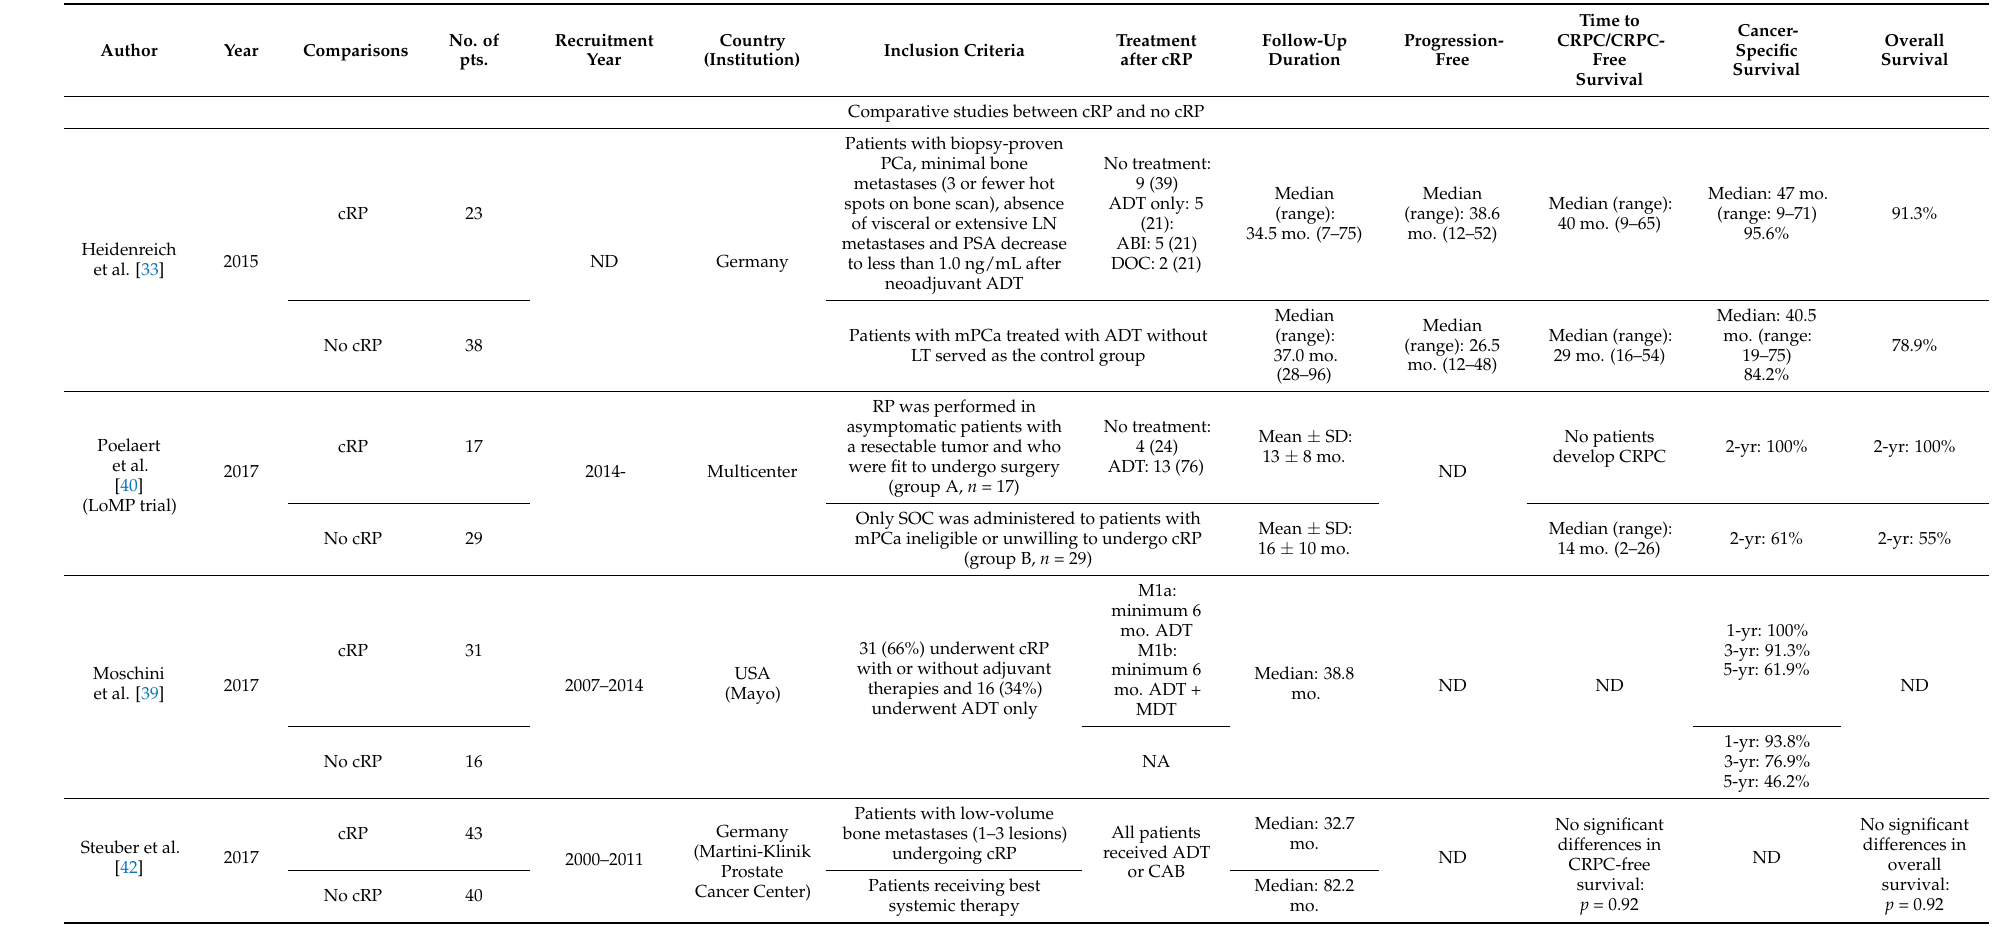
Table 2. Study demographics and oncologic outcomes of cohort